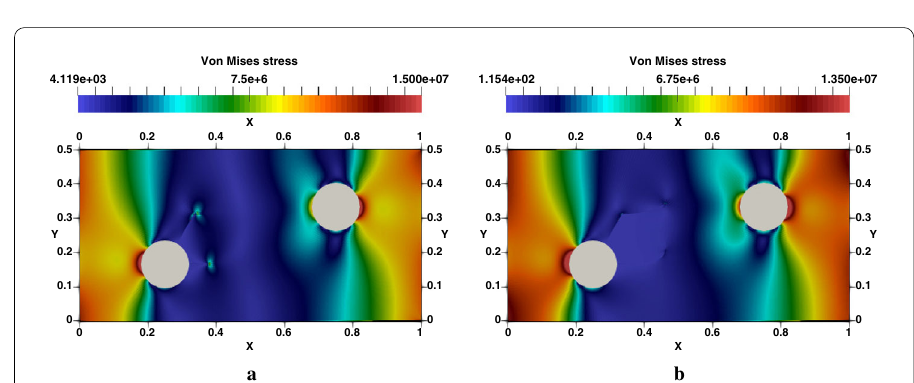
Fig. 28 Crack growth in plate with two circular holes and multiple cracks: von Mises stress— σ VM ; a initial state, b 13 (cid:14) a